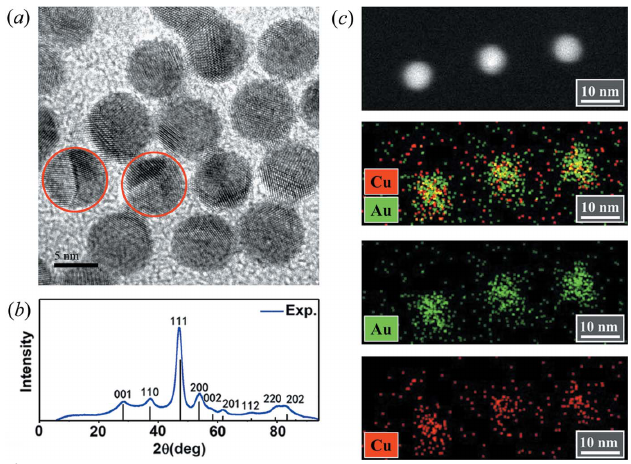
Figure 1 Morphology and elemental distribution of intermetallic AuCu NPs. ( a ) Low-magnification TEM of AuCu intermetallic NPs with a 6 nm diameter. Two MTPs are indicated by red circles. ( b ) XRD and ( c ) STEM-EDS mapping of intermetallic AuCu NPs.